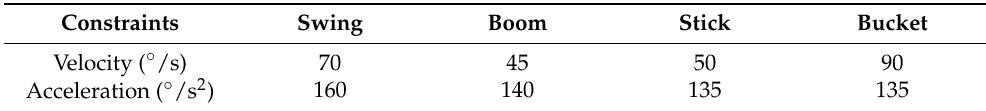
Table 2. Kinodynamic feasibility constraints of the